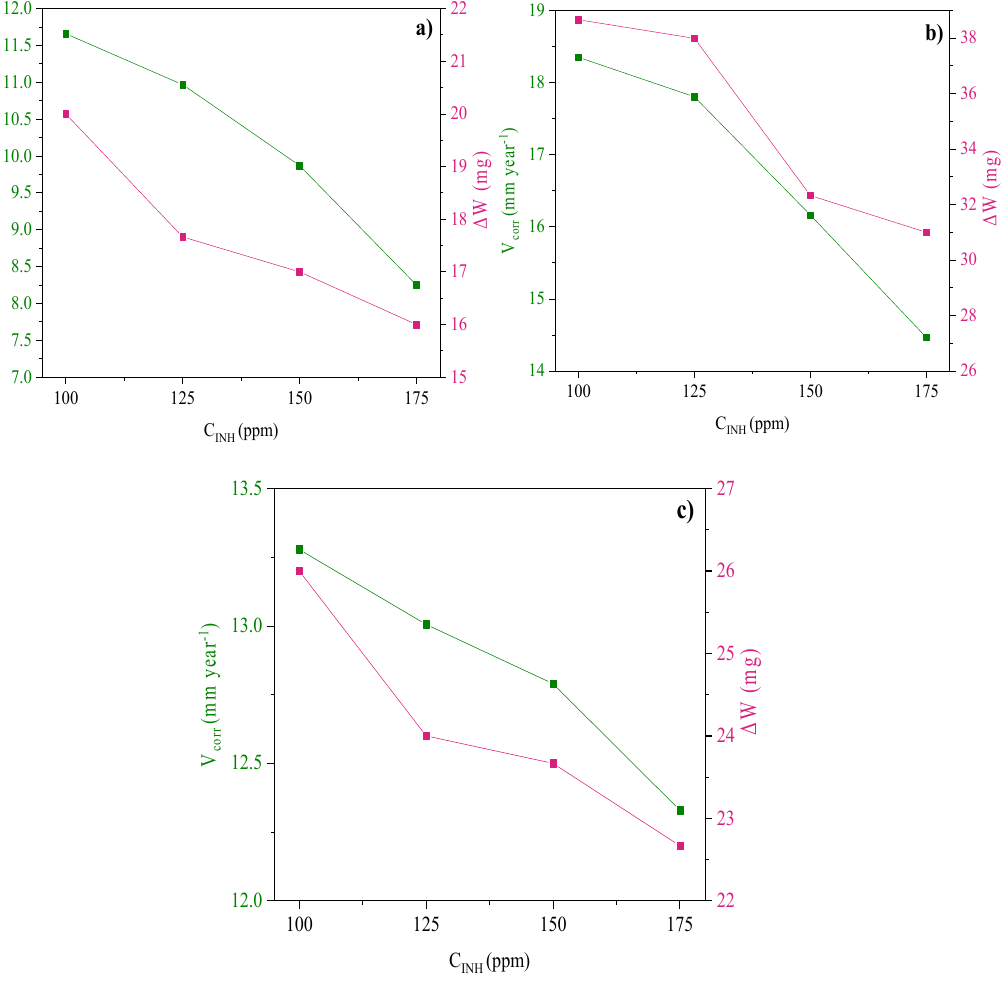
Figure 1. Corrosion rate (V corr ) and mass loss ( ∆ W) of API 5L X60 steel after 4 h of immersion in 1 M H 2 SO 4 and di ff erent C INH : ( a ) Poly[VIMC4][Im], ( b ) Poly[VIMC2][Br] and ( c ) Poly[VIMC4][Br] at 308 K.